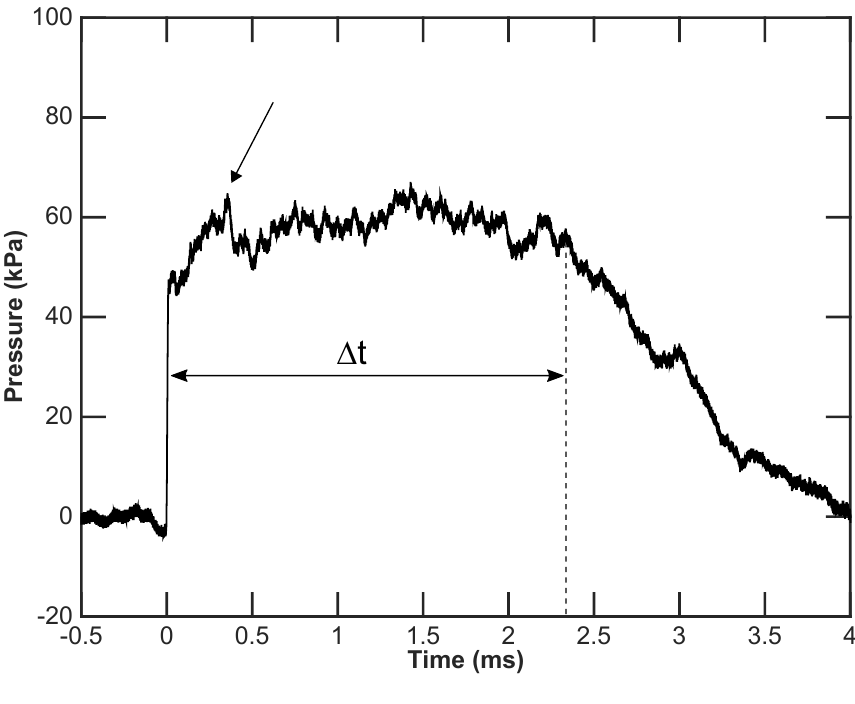
with no obstacle in the test section. 1